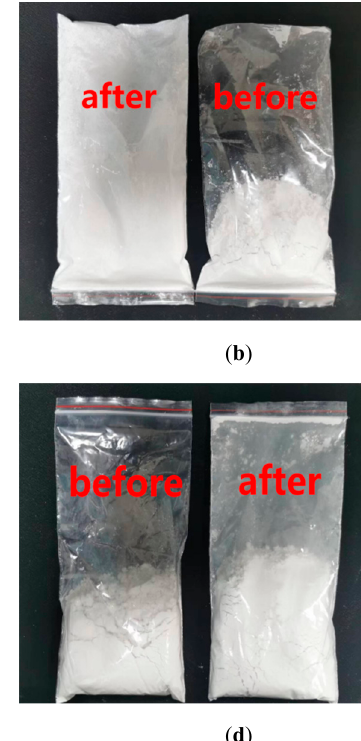
Figure 2. Appearance of functional fillers before and after surface modification. (a) Titanium diox- ide, (b) Silicon dioxide, (c) Hollow glass microspheres, (d) Sericite powder. ( b ) Silicon dioxide, ( c ) Hollow glass microspheres, ( d ) Sericite